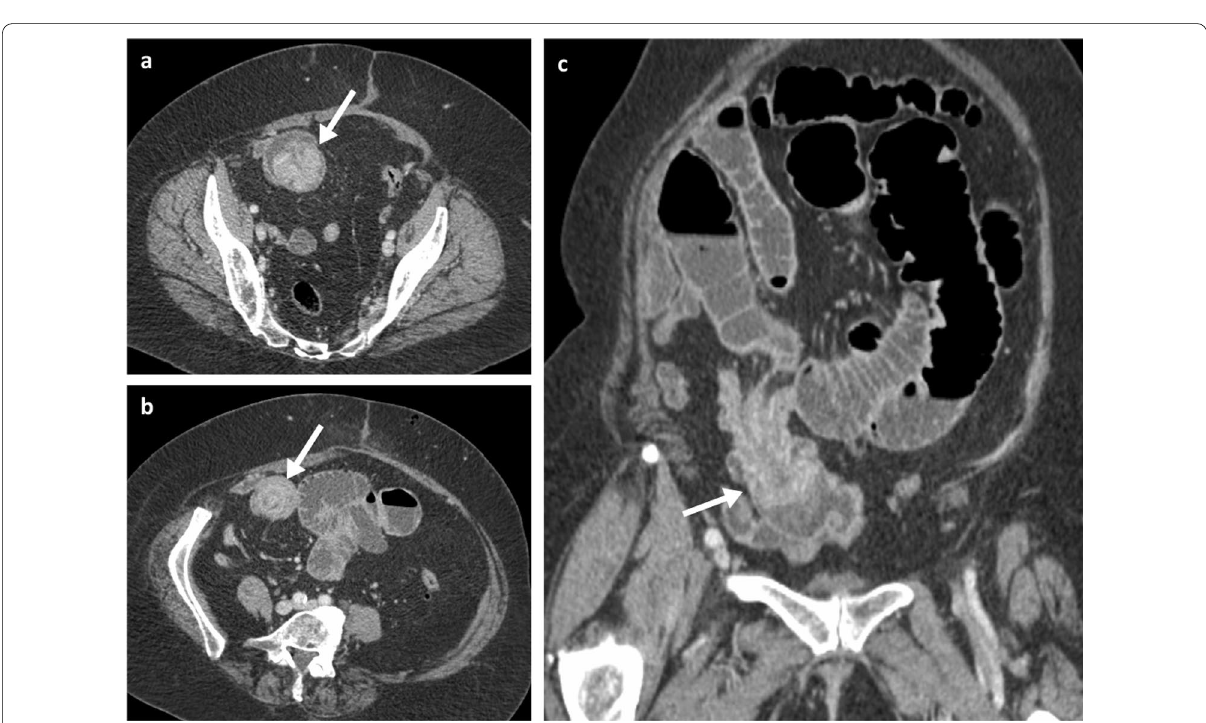
Fig. 8 Portal phase contrast-enhanced CT axial ( a , b ) and oblique coronal ( c ) of a 71-year-old female patient with ileal melanoma metastasis with resulting obstructing intussusception